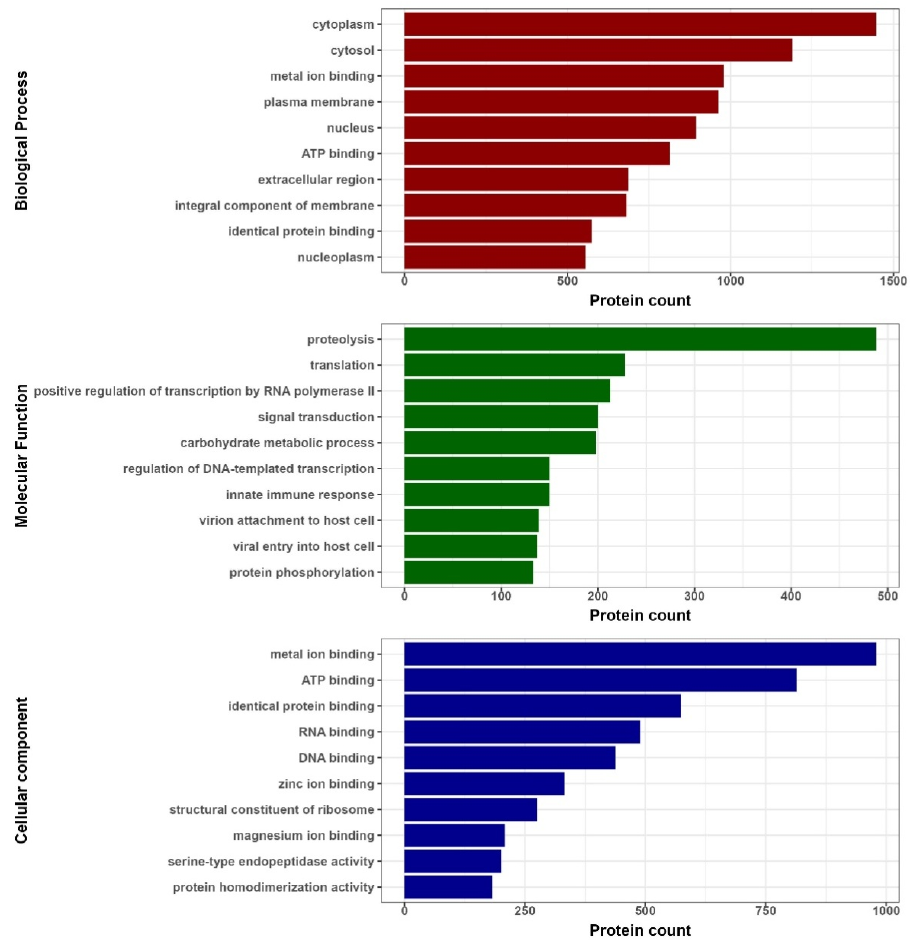
Figure 8. Biological functions of proteins in which any of the researched motifs were identified. Red bars correspond to biological processes, green bars correspond to molecular functions (MF) and blue bars correspond to cell compartments (CC).